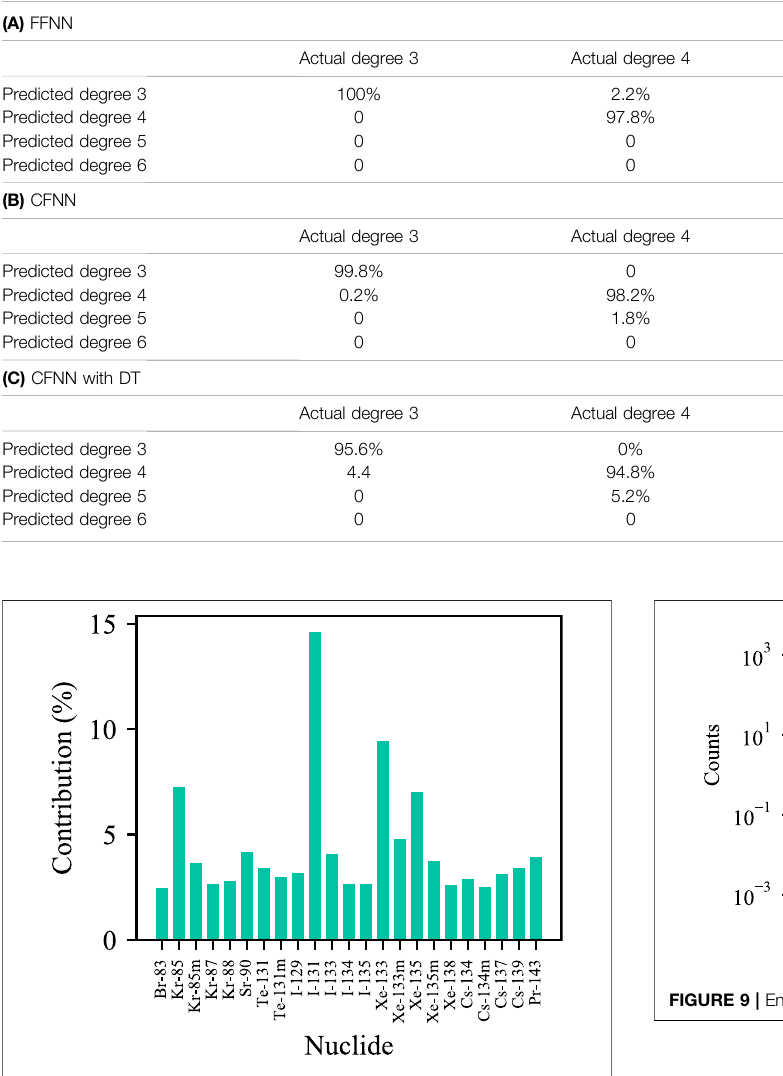
TABLE 3 | Confusion matrix of neural network results of the test set in percentage.